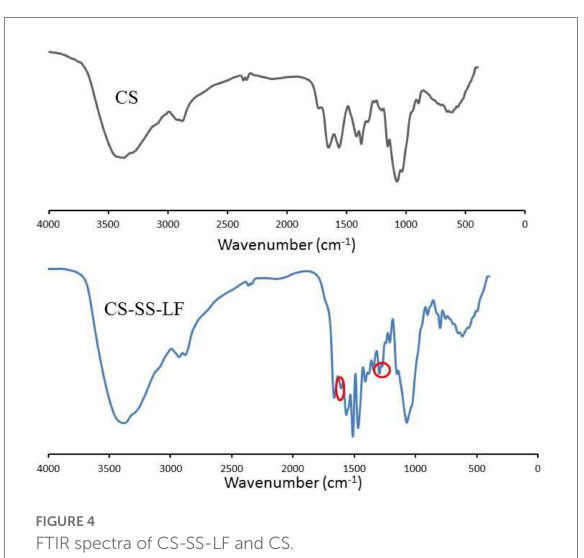
FIGURE 4 FTIR spectra of CS-SS-LF and